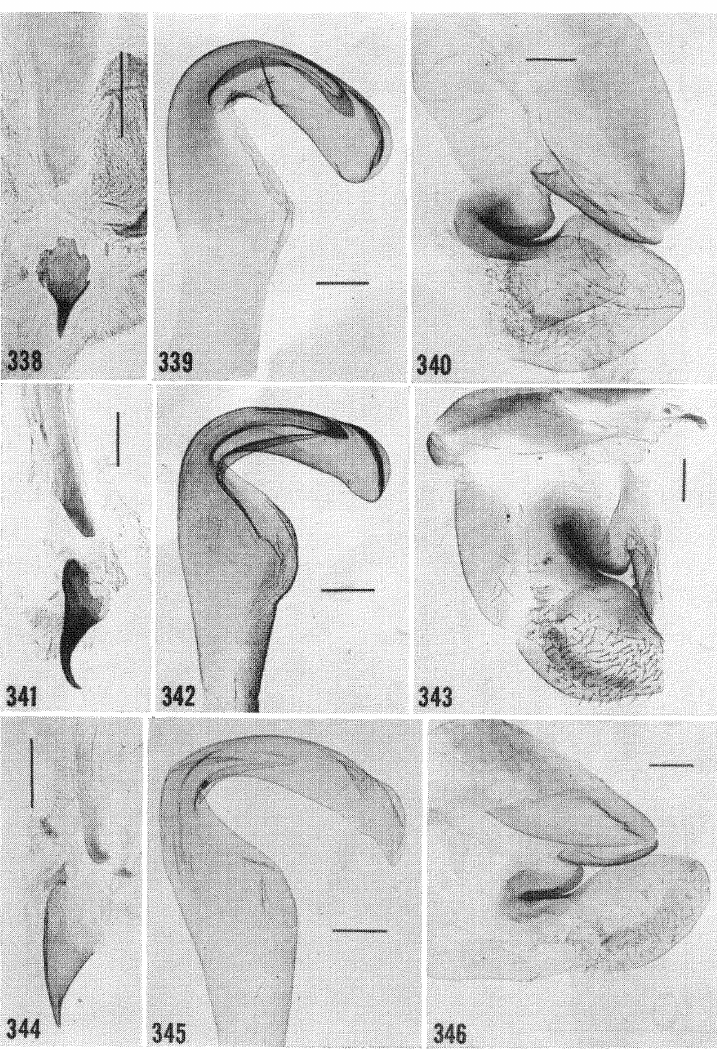
Figs. 338-346. Cockroach male genitalia. 338-343. Epilampra sp. B. 338-340. (10 BMNH). Pancina, Vera Paz. 341-343. (72 USNM). Territ. Amazonas, Mt. Marahuaca, Venezuela (det. as E. sodalis by Albuquerque). 344-346. (153 USNM). Epilampra sp. (near sp. B). Taken at Hoboken Quarantine (Venezuela?). (scale 0.2